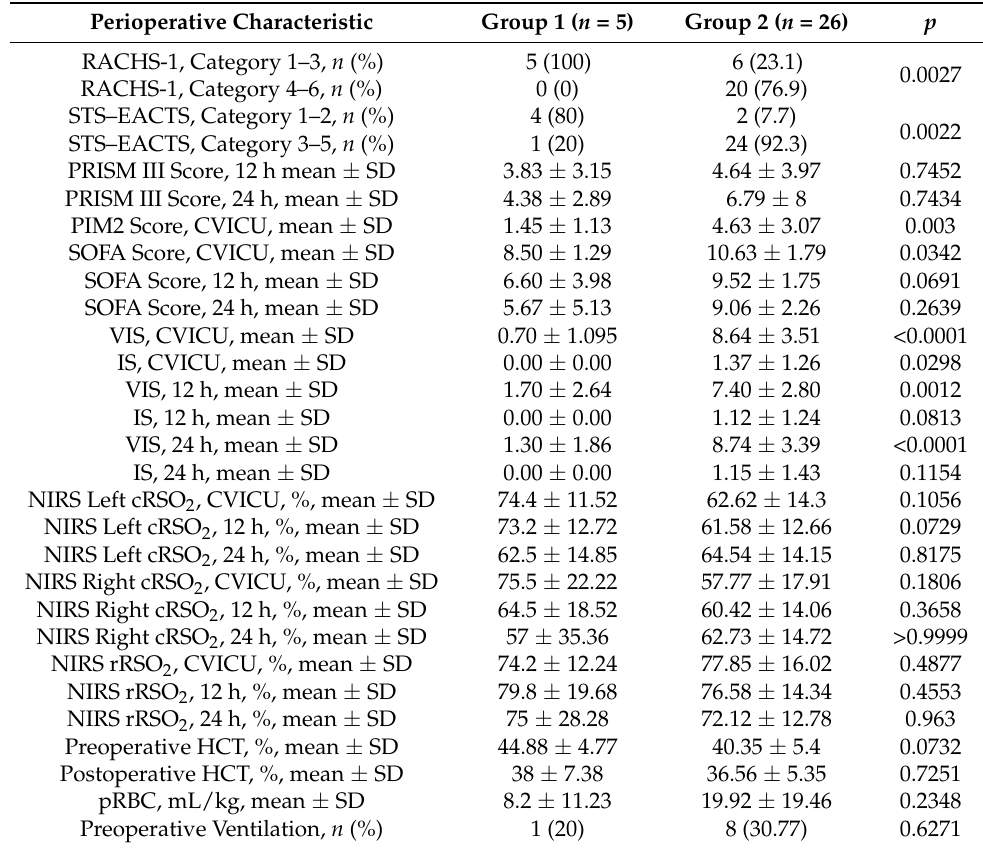
Table 1. Perioperative variables by